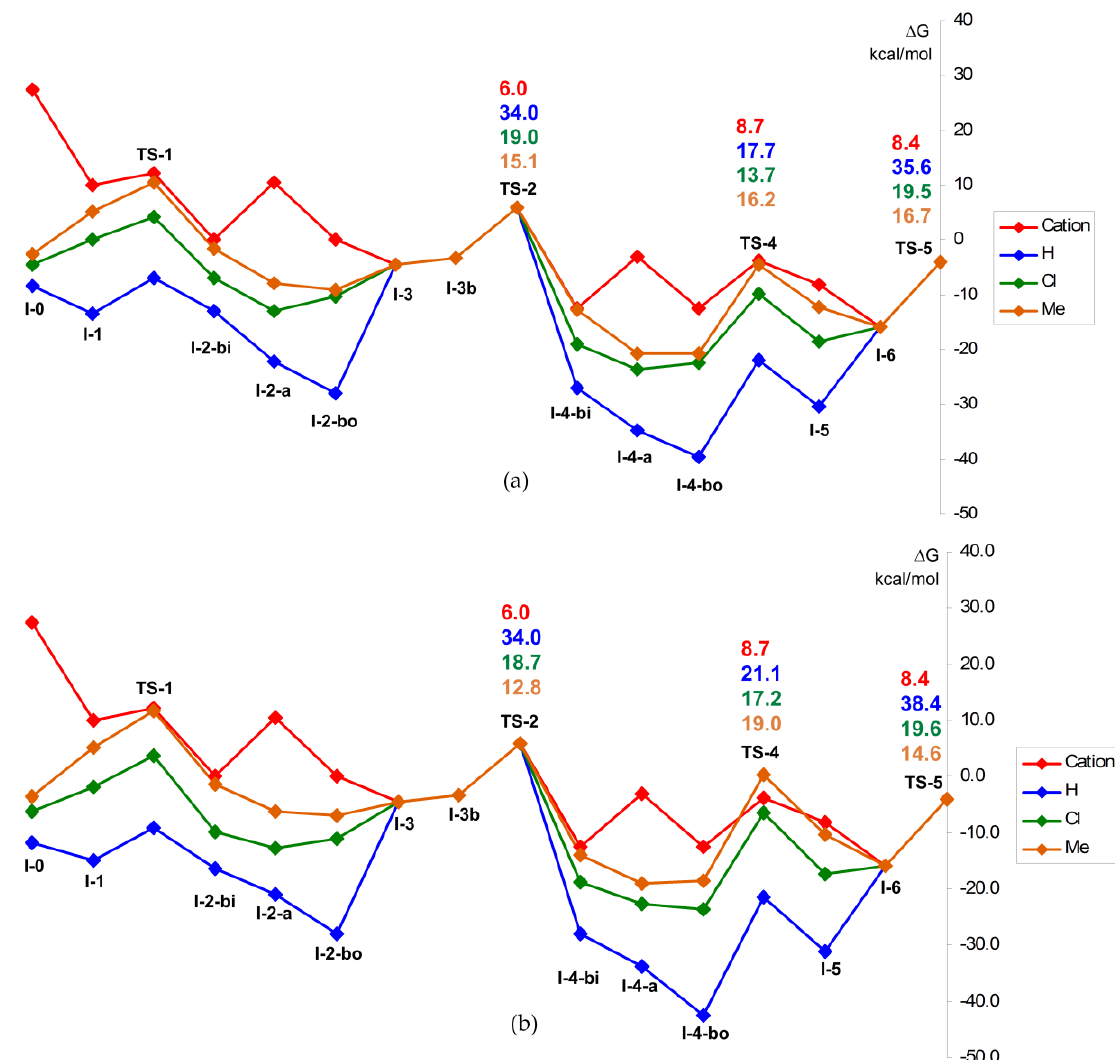
Figure 3. Reaction profiles for zirconocene-catalyzed oligomerization of propylene for mononuclear and binuclear reaction mechanisms for R = Me ( a ) and i Bu ( b ). The free energies of stationary points and transition states are presented relative to I-2_b . The free activation energies for insertion of the second propylene molecule (via TS-2 ), β -hydride elimination with a formation of dimer ( TS-4 ), and insertion of the third propylene molecule ( TS-5 ) are presented in color.